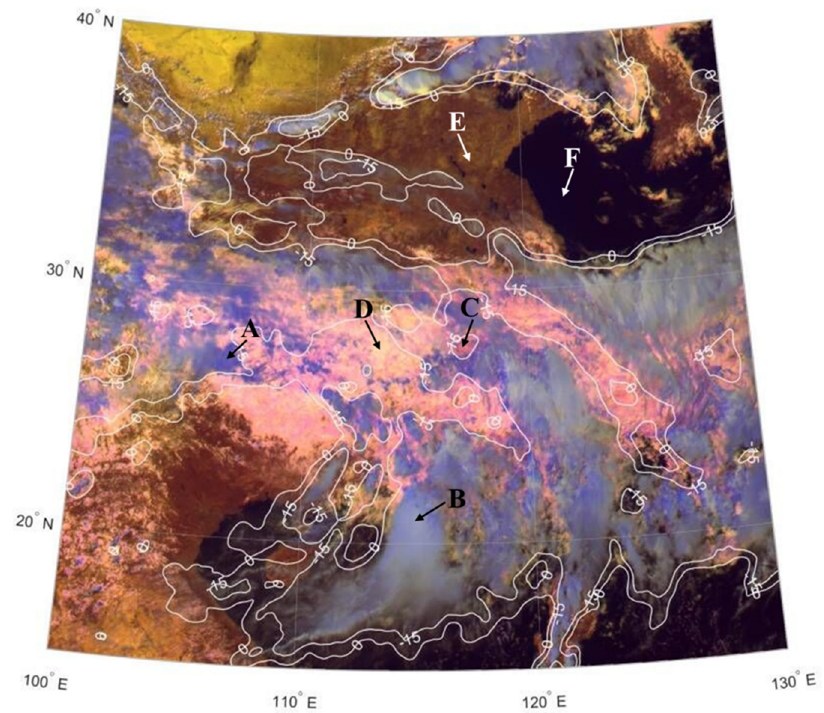
Figure 2. RGB composite image from FY-4A satellite at 06:30 UTC on 21 May 2020, superimposed with a 10.8 µm brightness temperature to obtain the distribution of supercooled cloud water. The white solid line is an isoline of the cloud top brightness temperature (°C) at the 10.8 µm channel of the satellite. A, B, C, D, E, and F represent deep ice clouds, thin ice clouds, precipitable clouds, water clouds, land, and sea, respectively.